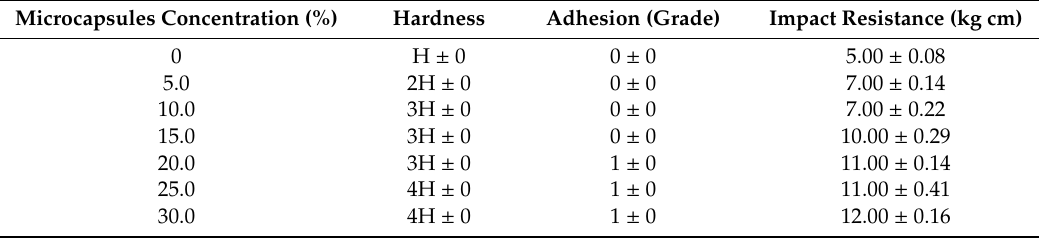
Table 5. E ff ect of microcapsule concentration on hardness, adhesion and impact